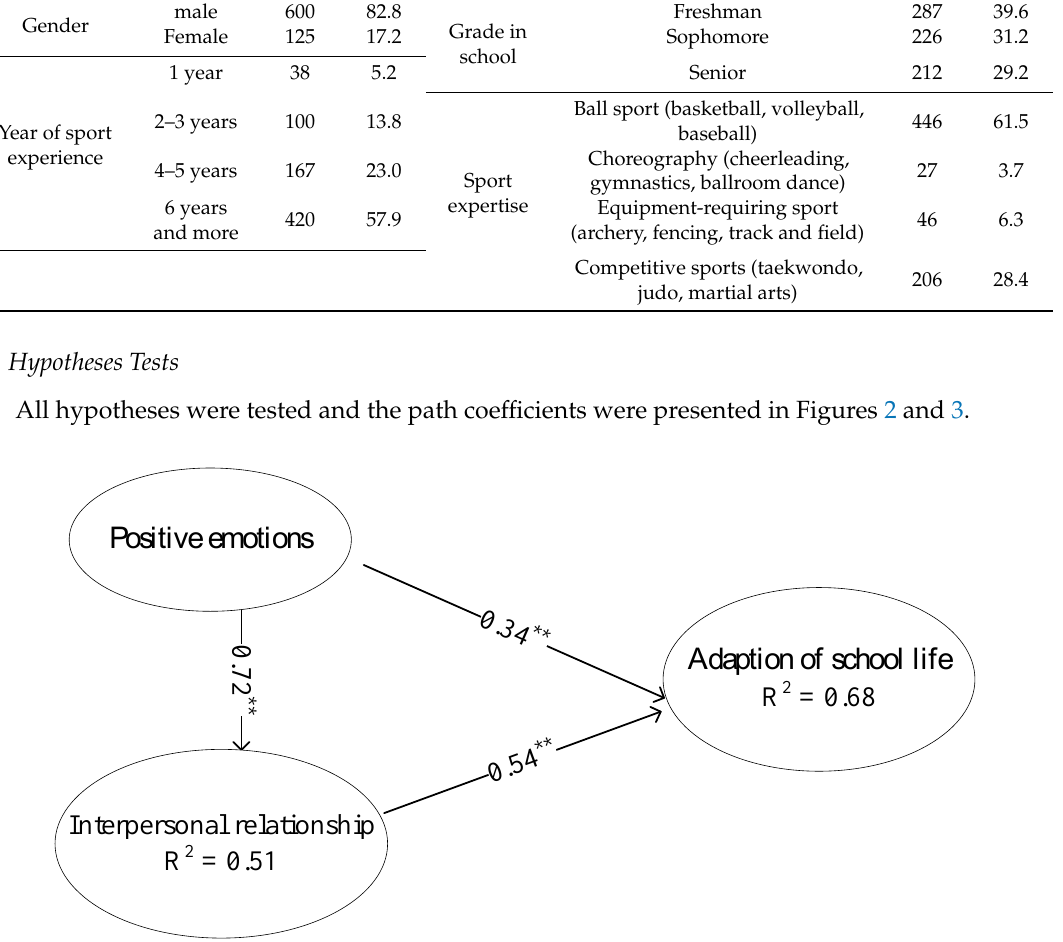
Figure 3. PLS results of the relationship between positive emotion and adaptation of school life. Note: ** p < 0.01.